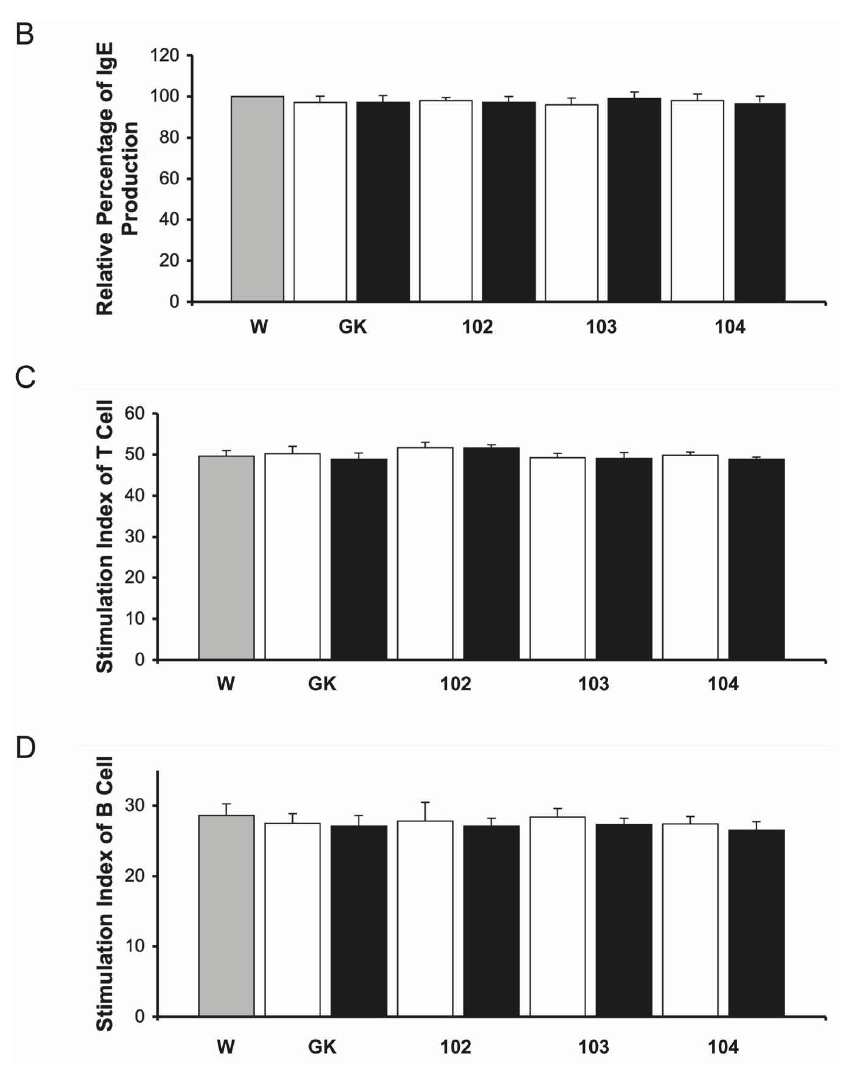
Table 6. Mean percentage of immune cells in mouse spleens after broccoli feeding. Broccoli Line, Level